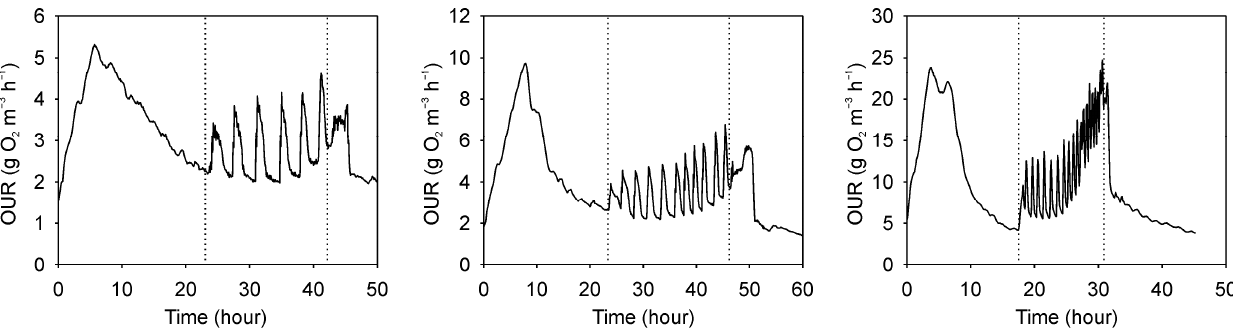
Figure 2. Results of three OUR experiments with 6, 11 and 20 consecutive additions of sulfide, respectively. The dotted vertical lines indicate the period with sulfide addition.